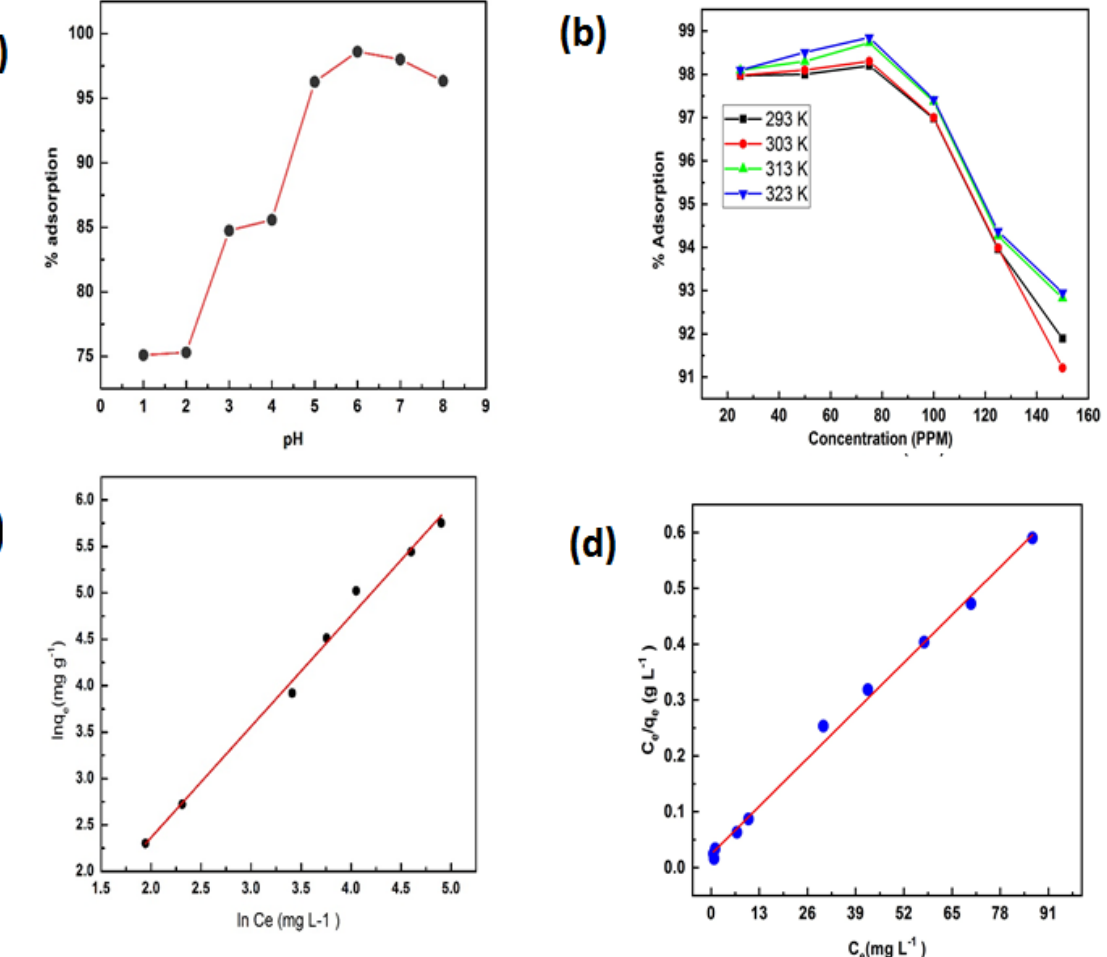
Figure 9. ( a ) Effect of pH, ( b ) effect of concentration, ( c ) Freundlich, and ( d ) Langmuir isotherms.